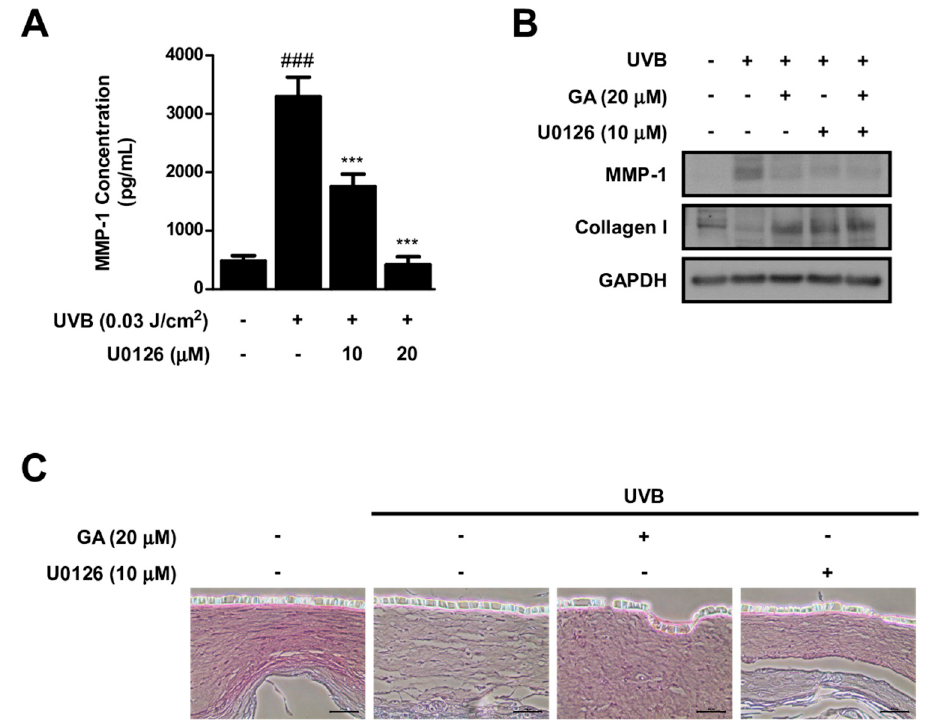
Figure 7. Effect of U0126 and gallic acid on MMP − 1 and collagen expression in reconstructed 3D human skin model. ( A ) HDFs were pre − treated with U0126. MMP − 1 concentration was measured using ELISA ( n = 3). Data represent the means ± SD. Significant differences between un − treated control and UVB − only treatment group (### p < 0.001) and significant differences between UVB and UVB + U0126 treatment group (*** p < 0.001). ( B ) Effect of GA and U0126 on MMP − 1 and collagen in a reconstructed 3D human skin model. GAPDH was used as a loading control. ( C ) Collagen was stained in sections from a reconstructed 3D human skin model using Sirius Red/Fast Green solution. The scale bar indicates 50 μ m.